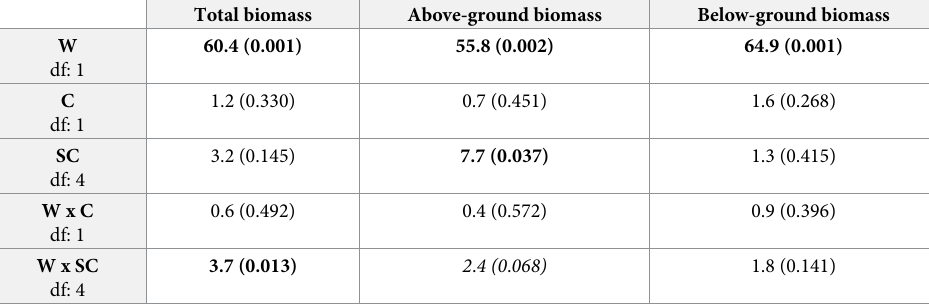
Values are F (P value) calculated using Mixed-effects ANOVA Analysis of Variance; Watering (W) and Culture (C) are fixed factors; Species Combination (SC) is a random factor; df: degrees of freedom. Numbers in bold highlight significant (p < 0.05) effects; numbers in italics highlight marginally significant effects (p <